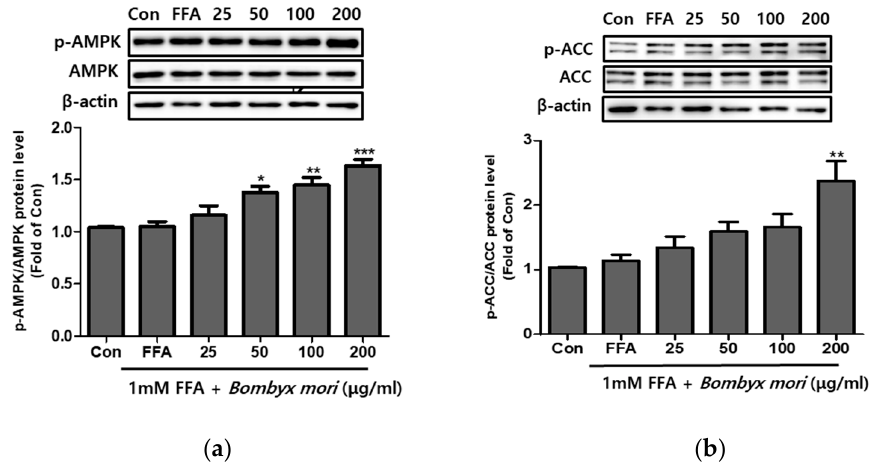
Figure 3. Effects of Bombyx mori (SW) on the expression of AMPK and ACC signaling in FFA-treated HepG2 cells. The expression of p-AMPK/AMPK ( a ) and p-ACC/ACC ( b ) were quantified by Western blot analysis. AMPK and ACC were used as a protein loading control of phosphorylated AMPK (p-AMPK) and phosphorylated ACC (p-ACC), respectively. The results from three independent experiments are expressed as the means ± SE. * p < 0.05, ** p < 0.01, and *** p < 0.001 vs.